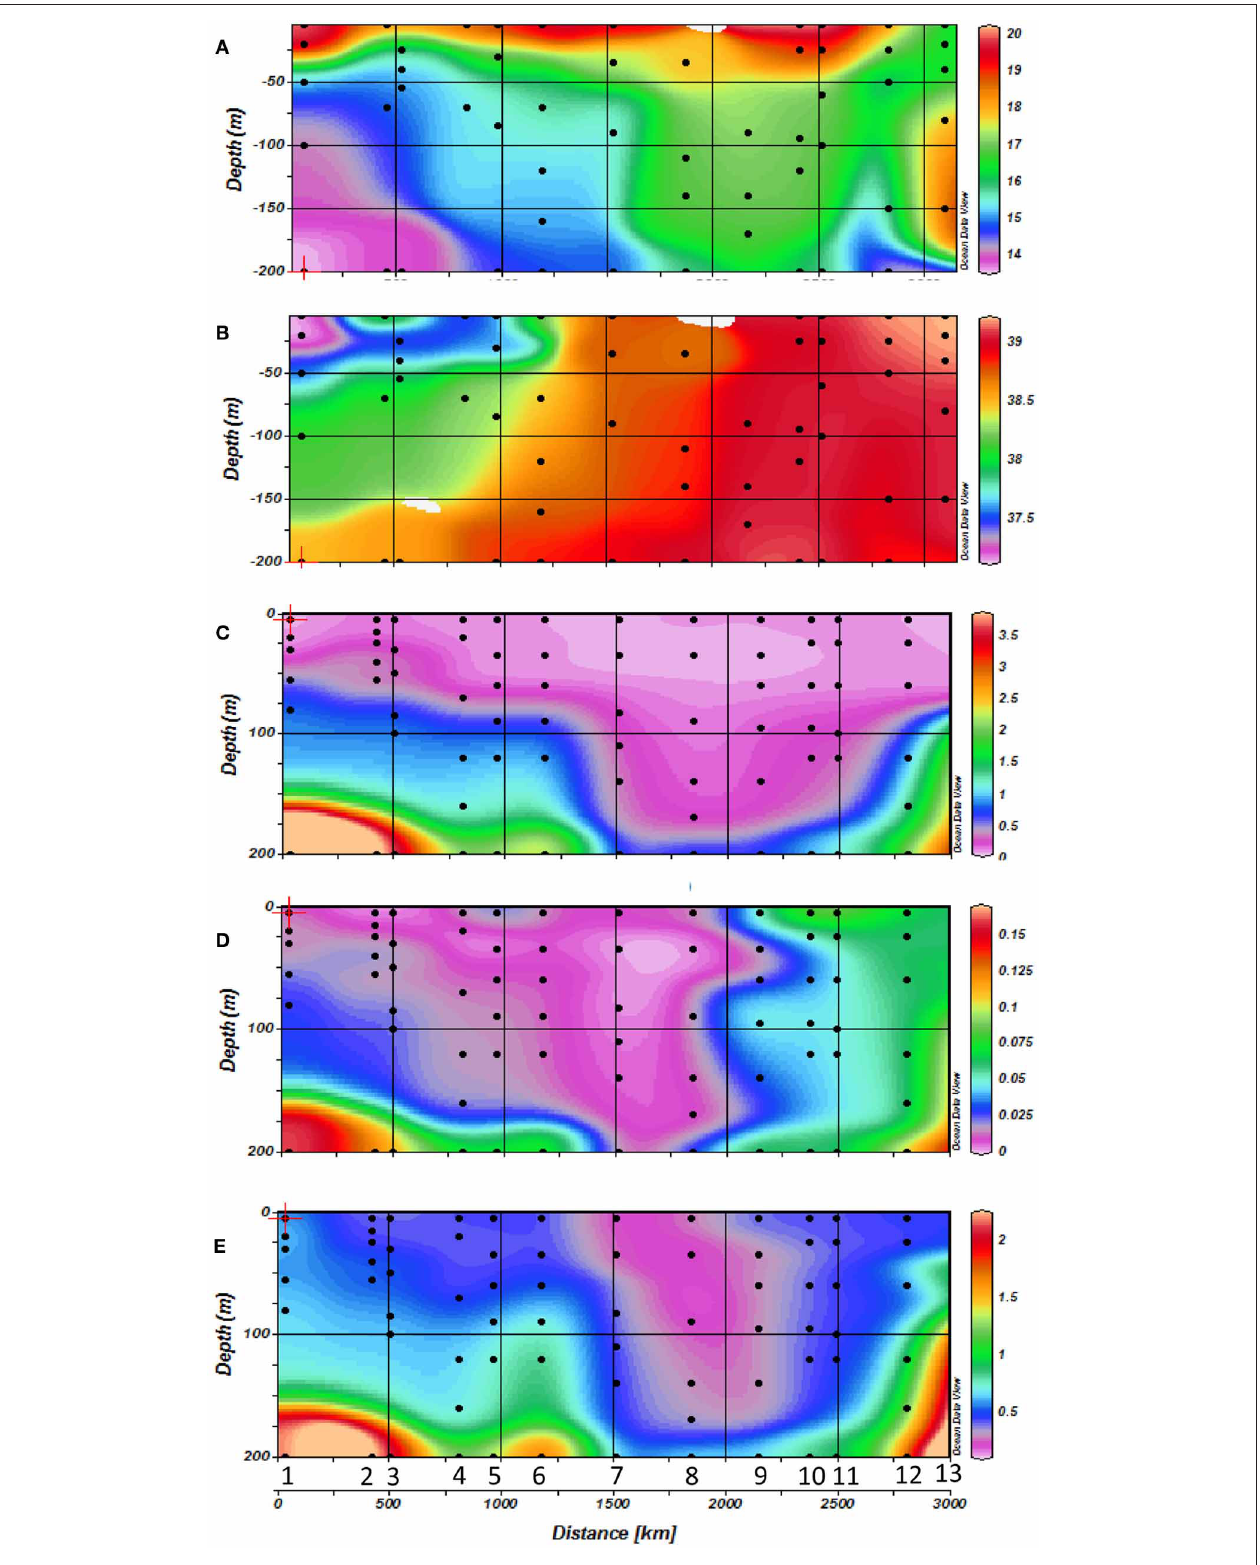
FIGURE 2 | Horizontal and vertical distribution of (A) temperature, (B) salinity, (C) NOx concentrations, (D) PO 4 concentrations and (E) Silicate concentrations along the transect with station numbers (1–13) and sampling depths indicated by dots during cruise.